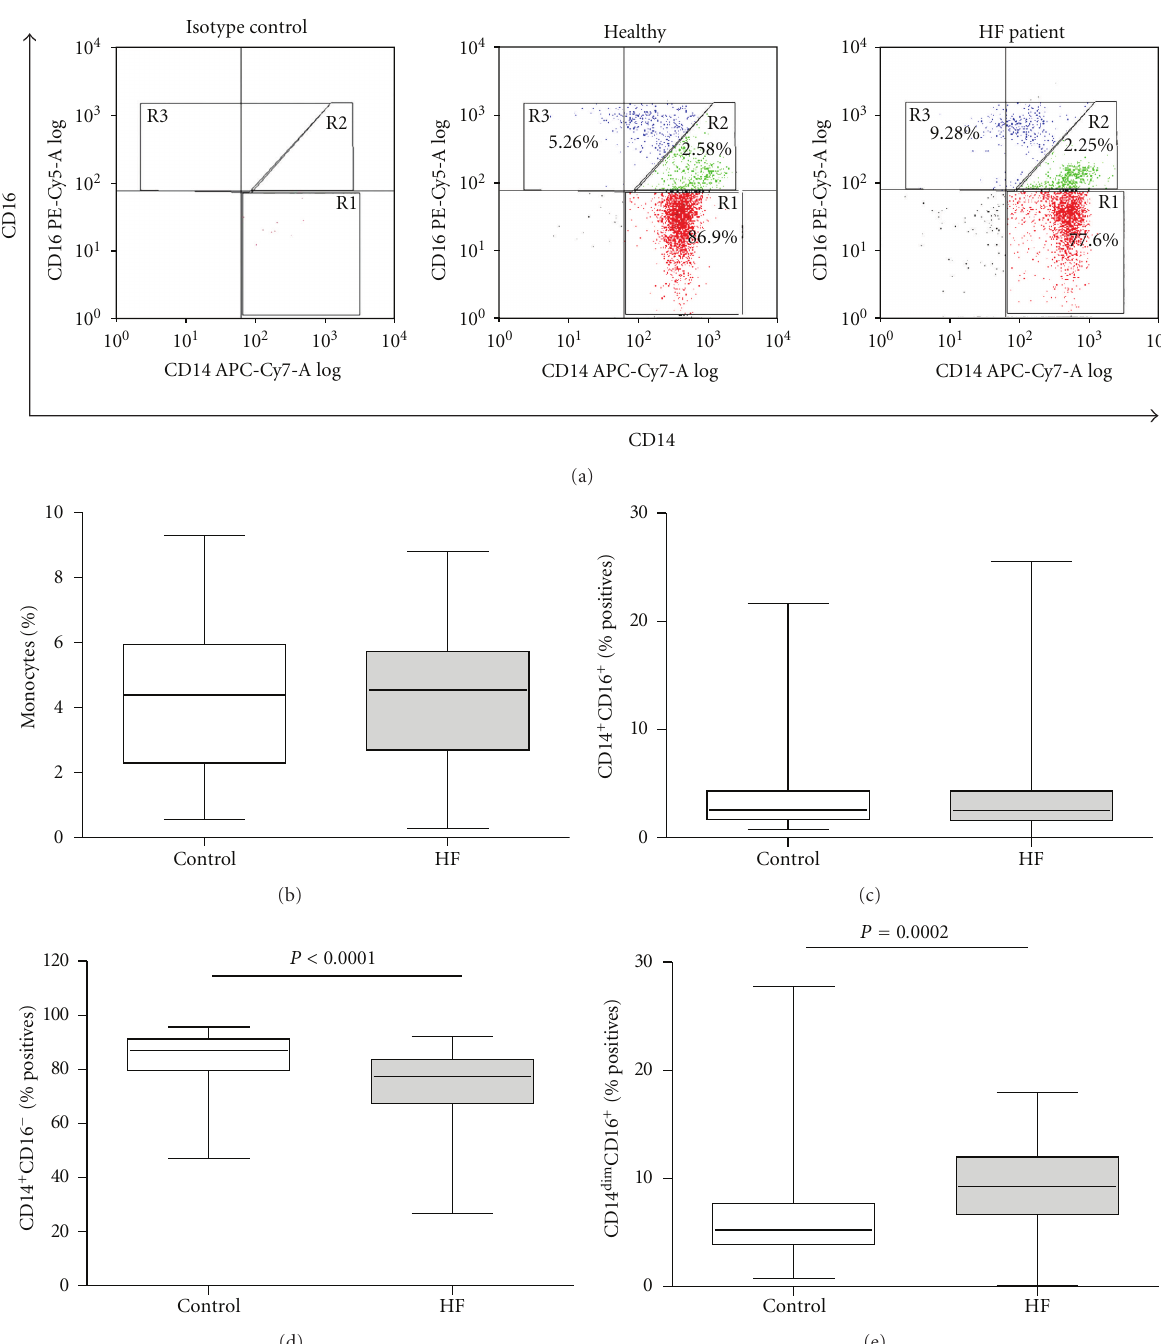
Figure 1: Characterization of monocyte subsets in HF patients and controls. (a) Representative flow cytometry dot plots of monocyte subsets in a healthy control and an HF patient, including the median values of each subset. Monocytes were gated by their side and forward scattering, and (b) their percentage from total blood leukocytes was determined; monocytes that were positive for HLA-DR expression were separated into three subsets according to their expression of CD14 and CD16, and their percentage of the total monocytes was determined in (c) CD14 + CD16 + monocytes (gated R2 in (a), the green subpopulation), (d) CD14 ++ CD16 − monocytes (gated R1 in (a), the red subpopulation), and (e) CD14 dim CD16 + monocytes (gated R3 in (a), the blue